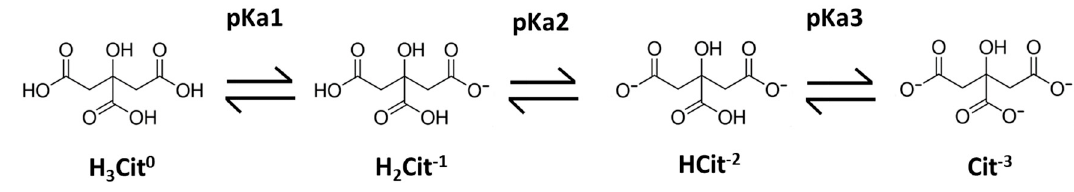
Figure 1. Chemical equilibria of citrate in aqueous Figure 1 . Chemical equilibria of citrate in aqueous solution.